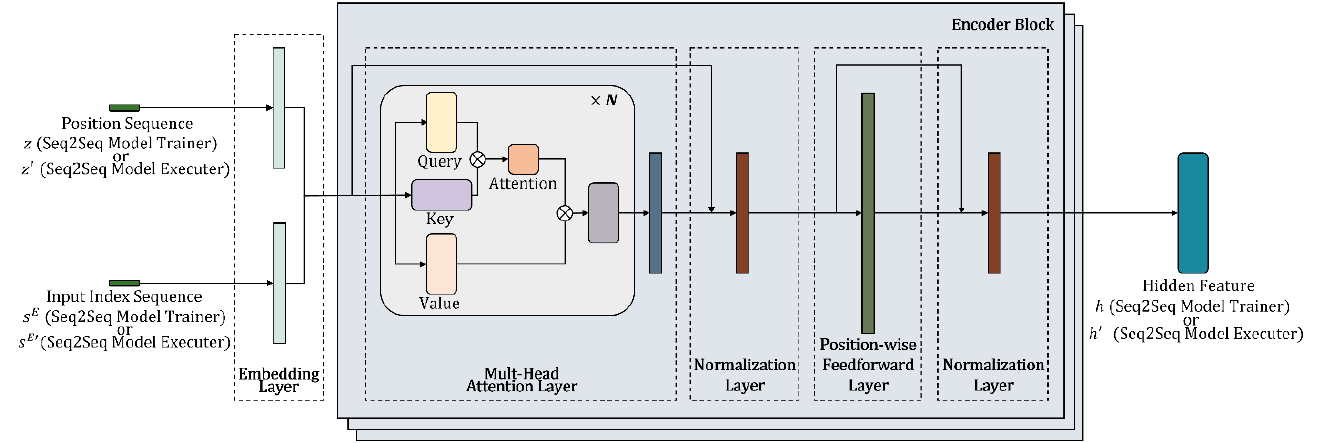
Figure 8. Encoder of the Seq2Seq model.